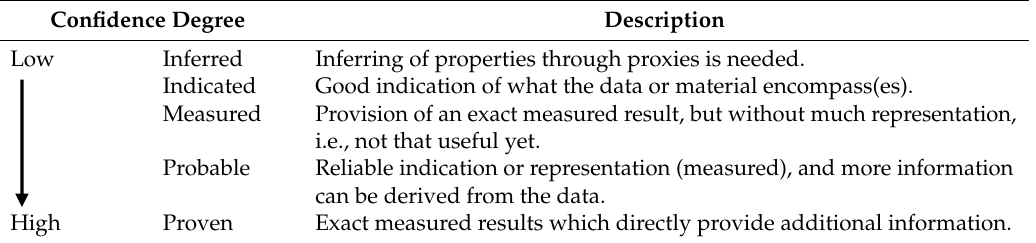
Table 1. Terminology on the degree of confidence of data.